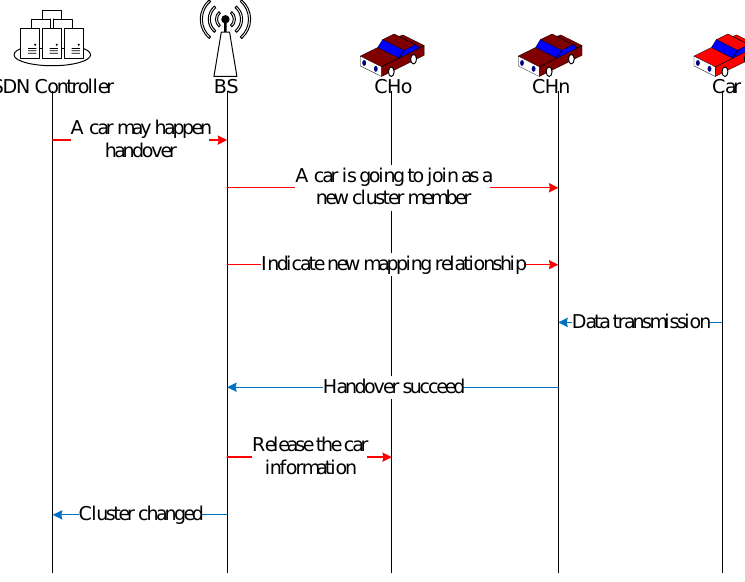
Figure 3. Action setting in